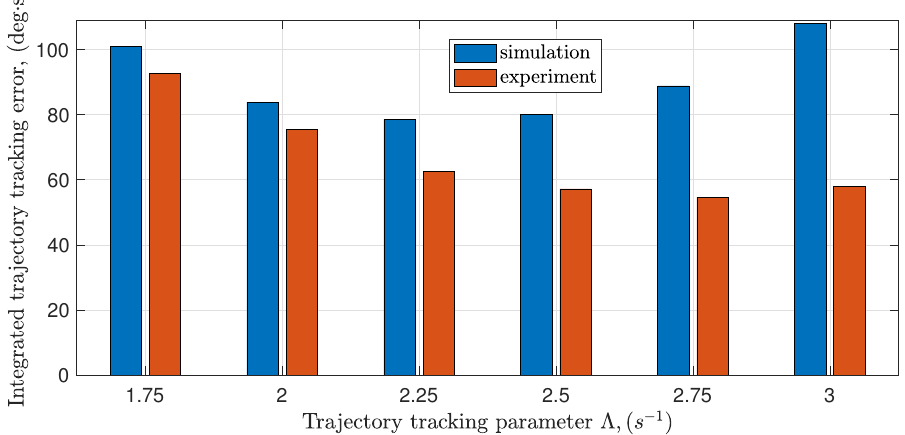
Figure 9. Absolute integral errors from simulations and